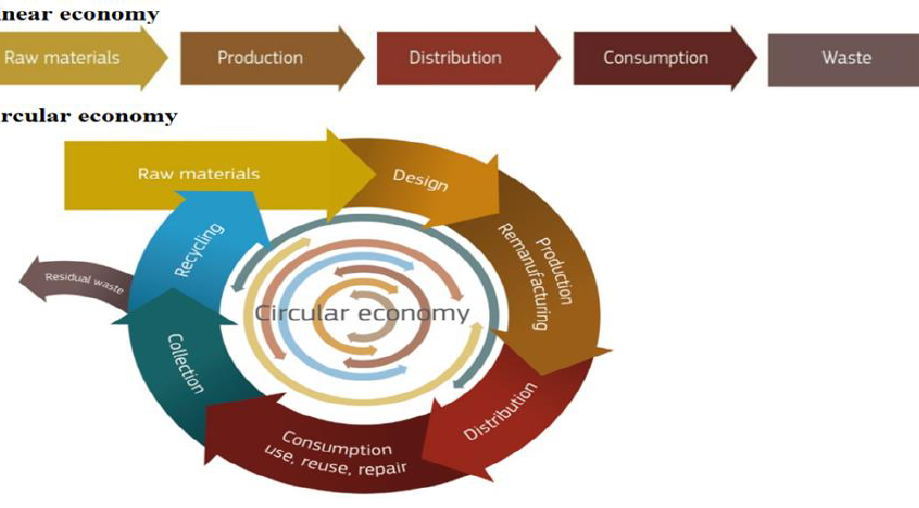
Fig. 3 . The linear (LE) versus the circular economy (CE) . Source: European Commission [49], p.